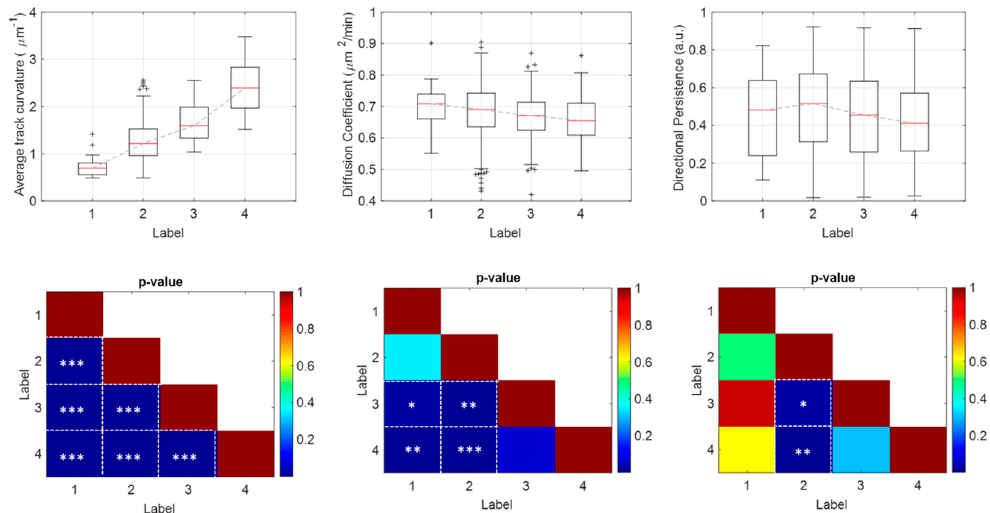
Figure 5. Single-descriptor analysis. In the first row, the box-plots of the average track curvature (left), of the diffusion coefficient (center) and of the directional persistence (right), respectively, extracted from sub-tracks assigned to confined, isotropic and directed random walk, and belonging to the four classes of drug concentration labeled as 1, 2, 3 and 4. In the second row, the triangular matrix of p - values for the Student’s t-test test with Bonferroni’s correction corresponding to the three descriptors in the first row. Cells of the matrix with asterisks indicate p -values < 0.05. Specifically, * p -value < 0.05, ** p -value < 0.01, *** p -value < 0.001.